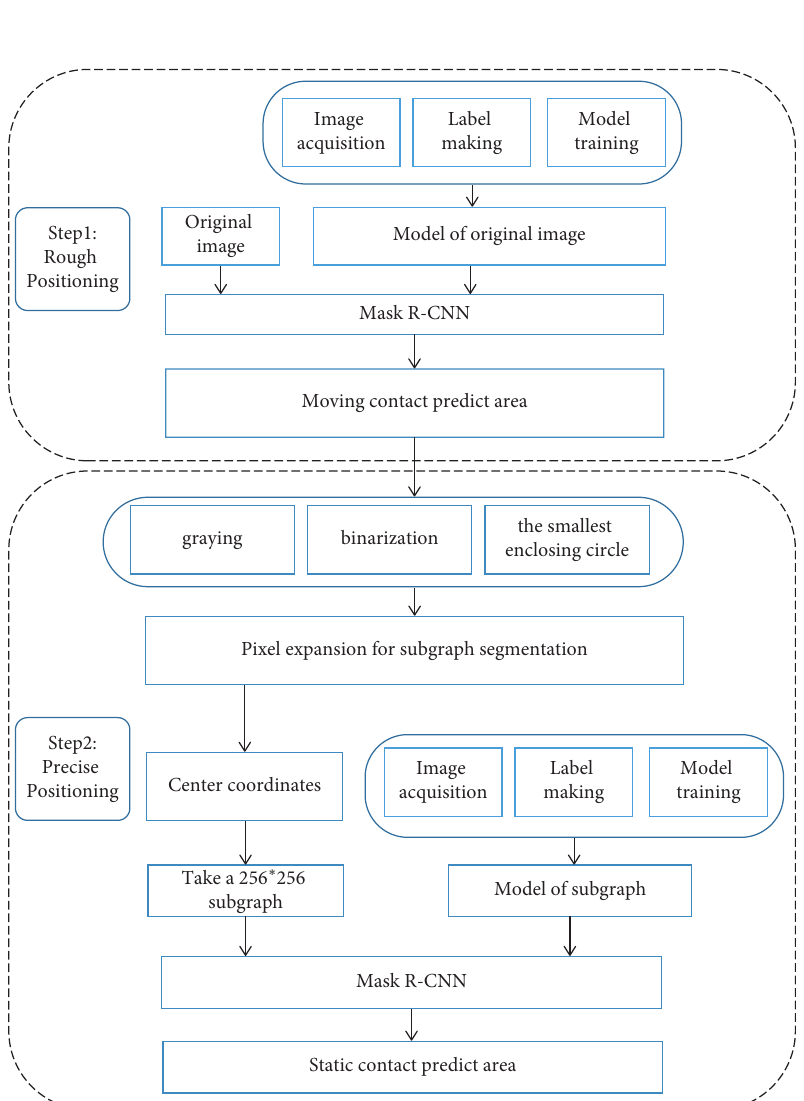
Figure 3: Framework of the positioning of switch machine moving and static contact based on DLM.